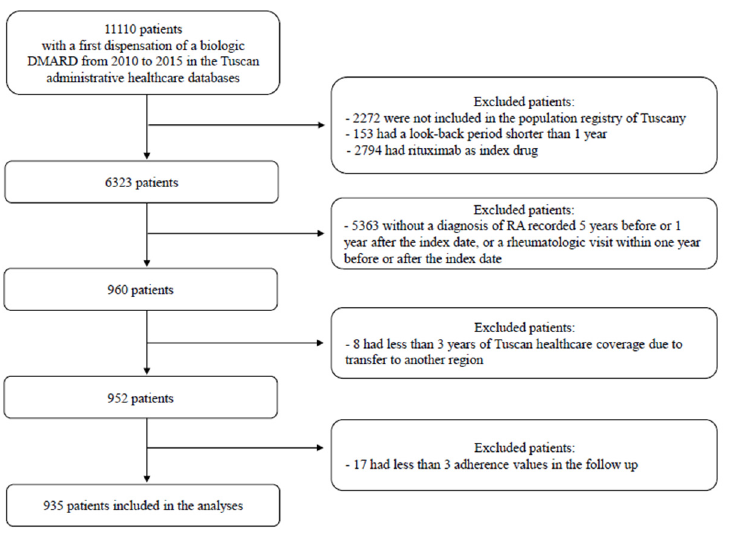
Figure 1. Study flow chart. DMARDs: Disease-modifying Anti-Rheumatic Drugs; RA: rheumatoid arthritis.